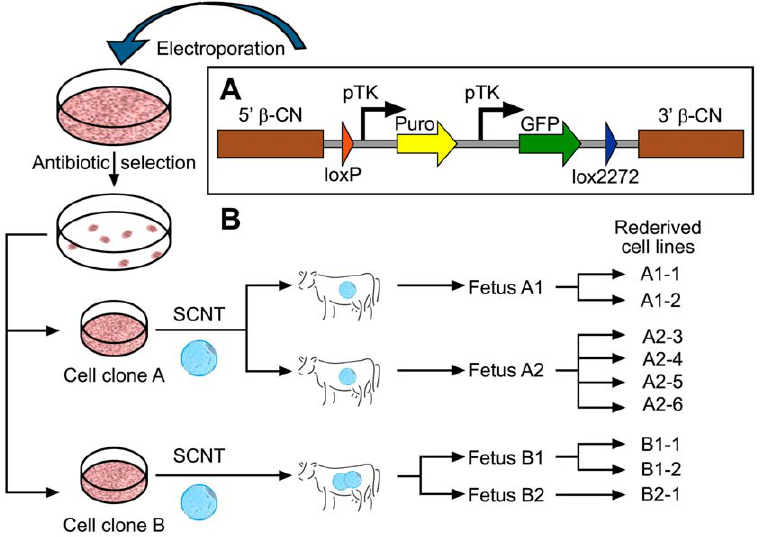
Figure 1. Transgene construct and cell line isolation and rederivation scheme. (a) The transgene construct is comprised of a puromycin- resistance gene (Puro) and an EGFP gene (EGFP), each driven by an individual TK promoter (pTK) and flanked firstly by a pair of incompatible lox sites (loxP, lox2272) and secondly homologous sequence arms of the bovine beta-casein promoter (5 9 b -CN) and 3 9 untranslated region (3 9 b -CN). (b) Primary bovine cells were transfected and cell clones isolated following antibiotic selection. Two cell clones (A and B) were chosen as source for donor cells to generate embryos using SCNT. Following transfer into recipient cows for further in vivo development, two resulting fetuses generated from cell line A (fetus A1, A2) and cell line B (fetus B1 and B2) were used to isolate a series of rejuvenated primary cell lines with the same genetics as the original cell lines A (A1-1, A1-2, A2-3, A2-4, A2-5, A2-6) and B (B1-1, B1-2, B2-1).